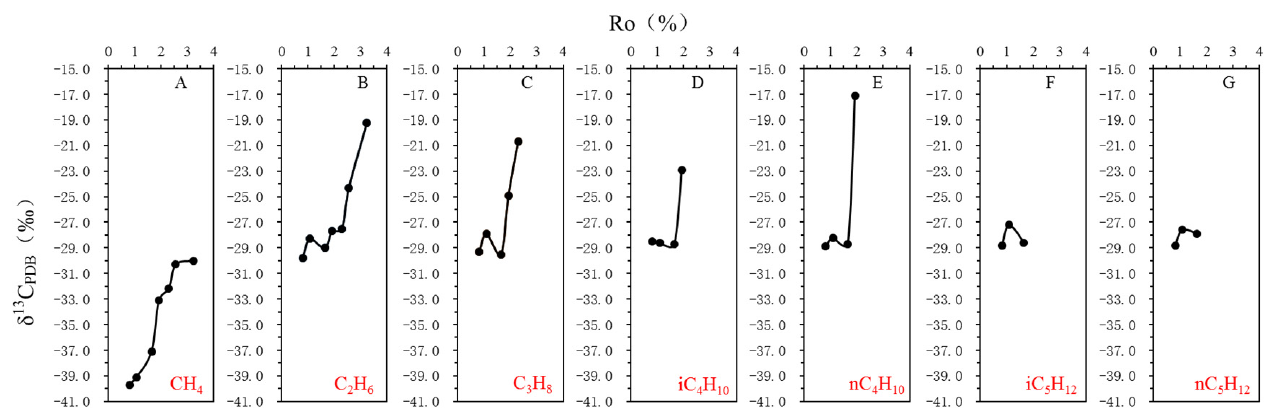
Figure 6. The variation trend of carbon isotopes on gaseous hydrocarbon products with Ro (( A – G ) respect the carbon isotopes of CH4, C2H6, C3H8, iC4H10, nC4H10, iC5H12, nC5H12, respectively).